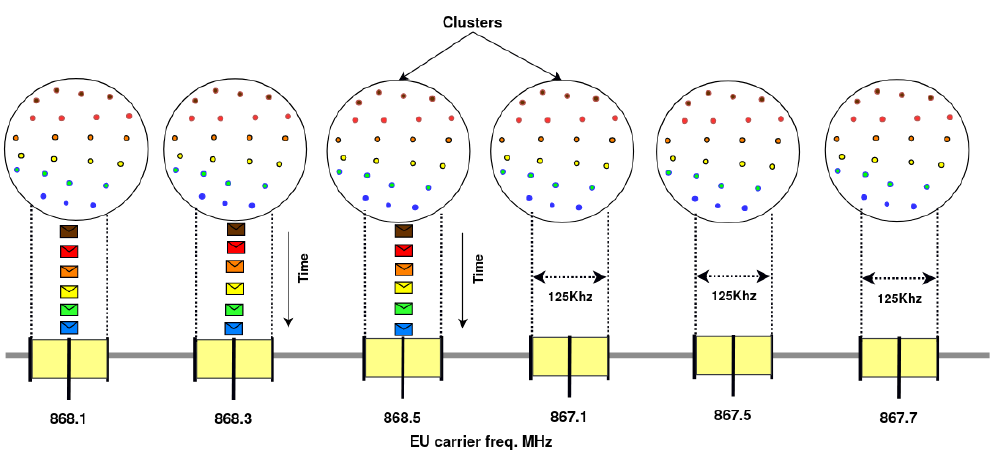
Figure 4. Transmissions with